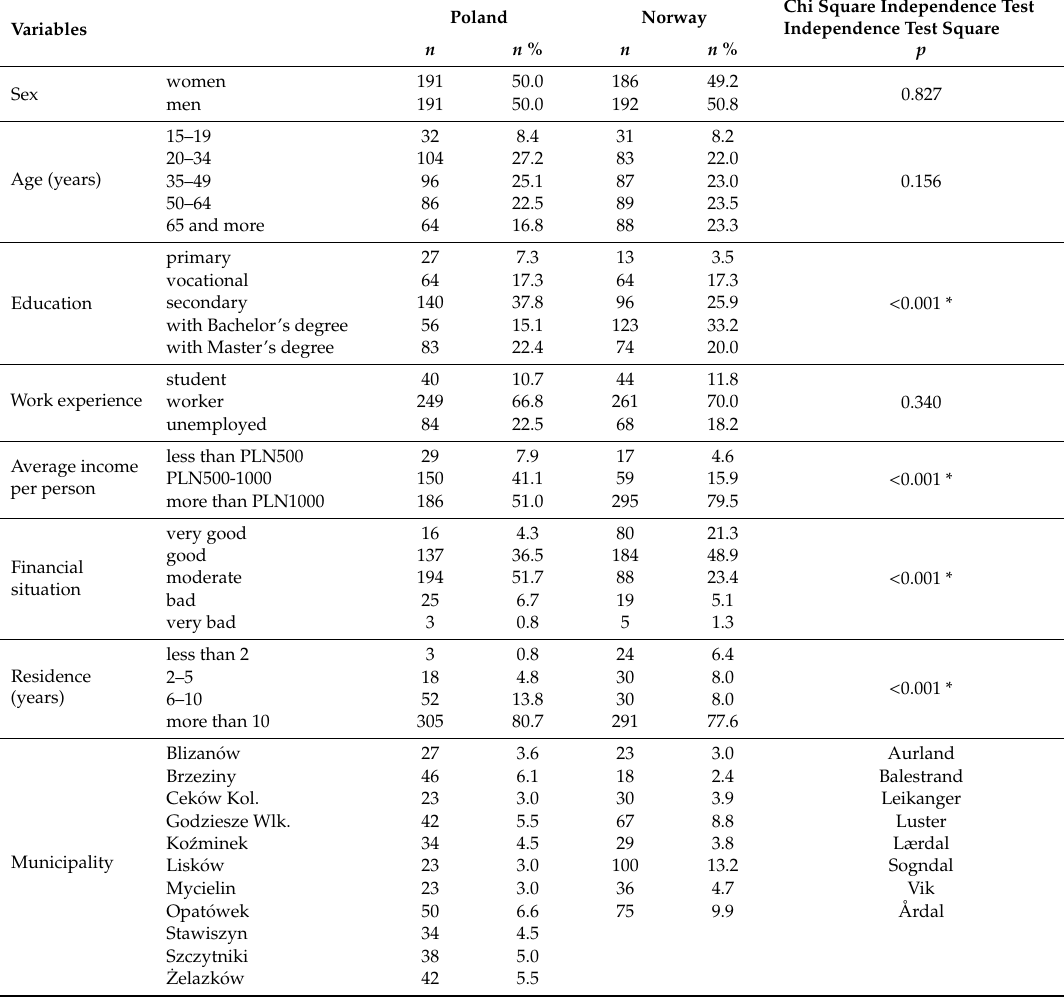
Table 1. Research group